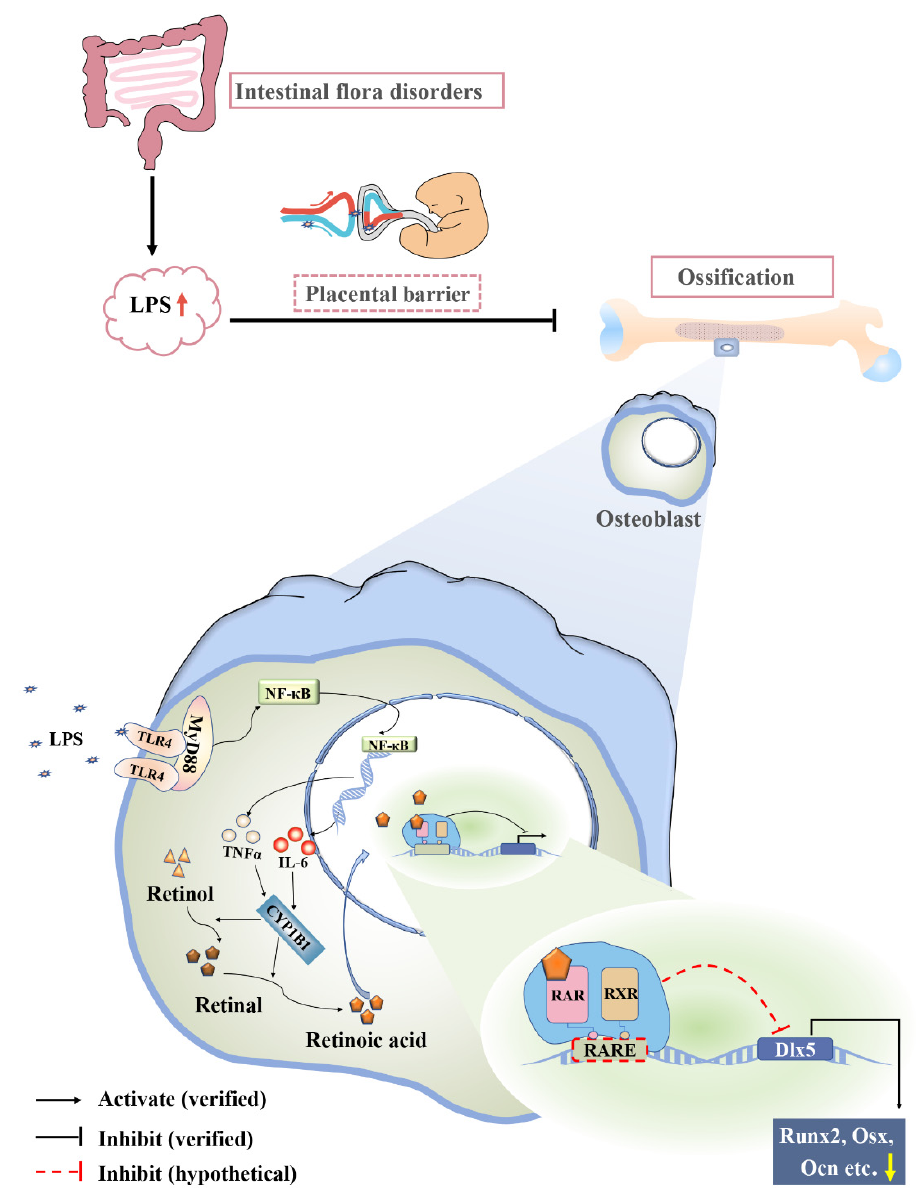
Figure 10. Proposed mechanism of RA-mediated Dlx5 expression in abnormal osteogenesis induced by dysbacteriosis-induced LPS elevation.